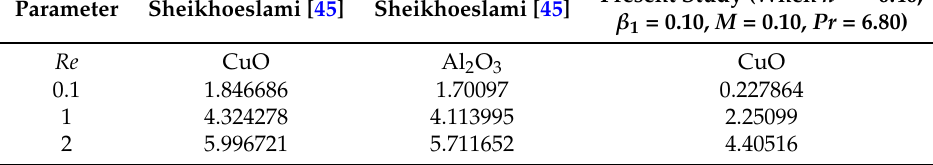
Table 6. Comparison of the effects of different kinds of nanoparticles on Nusselt number ( Nu ) as a function of Reynolds number Re when φ =